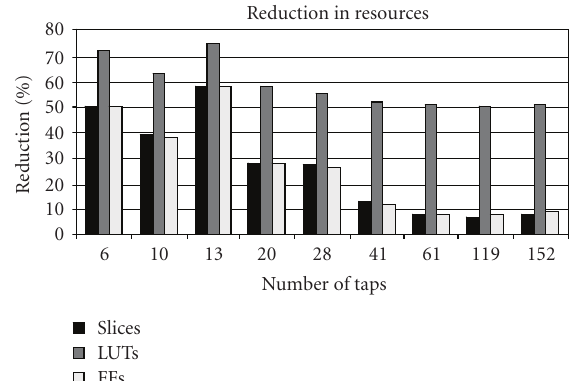
Figure 11: Reduction in resources for add and shift method (this paper) relative to that for DA showing an average reduction of 58.7% in the number of LUTs, and 25% reduction in the number of slices and FFs.